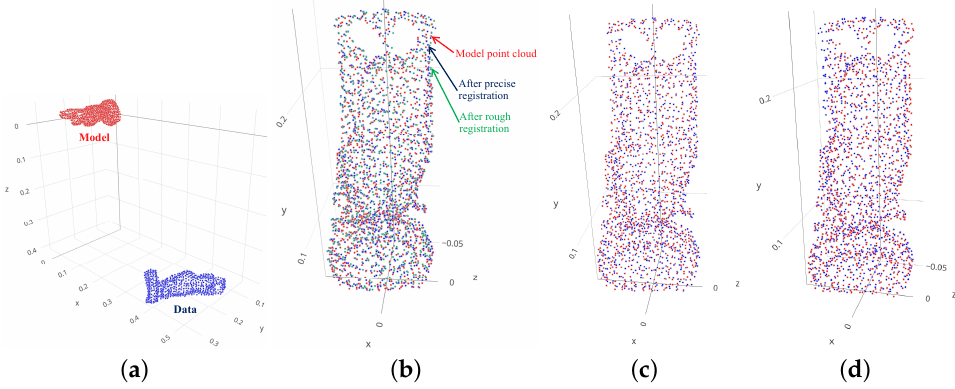
Figure 15. The registration results of Buddha data for test sample 7: ( a ) The initial state; ( b ) 3-D CNNs then 2-D CNNs, ( c ) RANSAC then ICP, ( d ) Fast Global Registration.